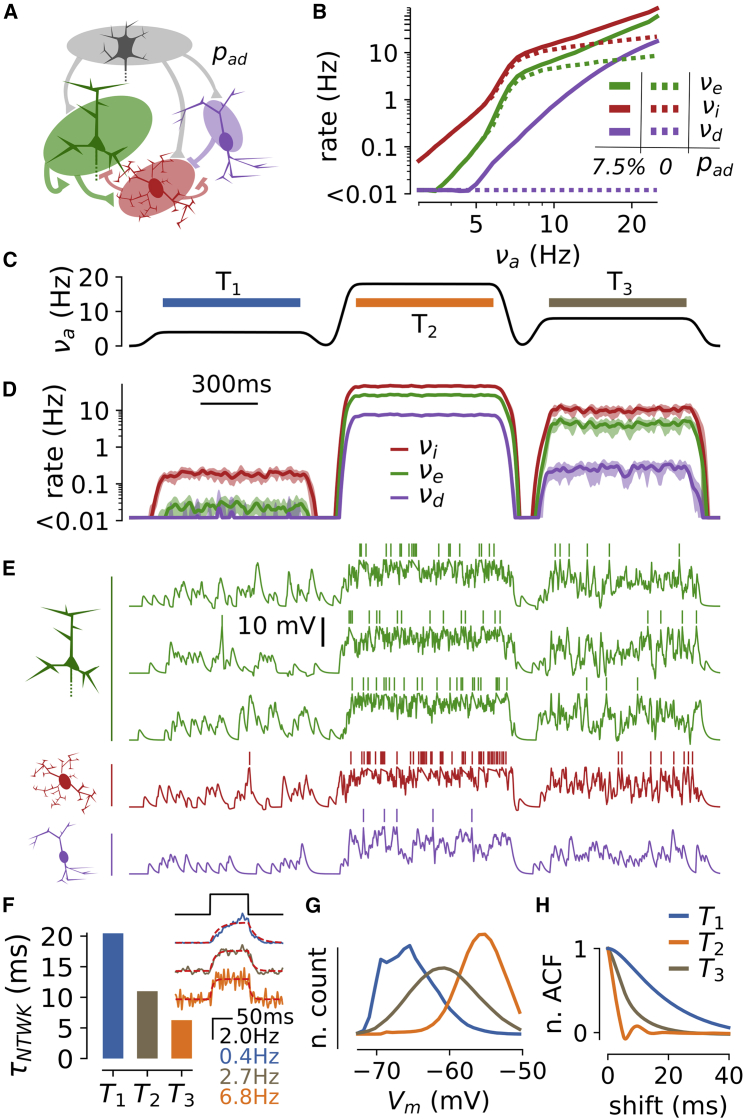
Modulation of Network Activity upon a Time-Varying Afferent Excitation(A) Schematic of the network model including the disinhibitory circuit. The parameter pad corresponds to the connection probability between the afferent and disinhibitory populations.(B) Stationary co-modulations of the excitatory (νe, green), inhibitory (νi, red), and disinhibitory (νd, purple) rates in absence (pad=0, dashed line; reproduced from Figure 1B) and in the presence of a disinhibitory circuit (solid line, pad=7.5%).(C–E) Network dynamics in response to a time-varying input.(C) Waveform for the afferent excitation.(D) Temporal evolution of the instantaneous firing rates (binned in 2-ms windows and smoothed with a 10-ms-wide Gaussian filter) of the excitatory (νe, green), inhibitory (νi, red), and disinhibitory (νd, purple) populations. Mean ± SEM over n = 10 trials. Time axis as in (C).(E) Membrane potential traces in a trial (green, excitatory cells; red, inhibitory cell; purple, disinhibitory). To highlight mean depolarization levels, the artificial reset and refractory mechanism has been hidden by blanking the 10 ms following each spike emission (see also Figure S6). Time axis as in (C).(F) Network time constants τNTWK for the three different levels of afferent activity considered in (C) (blue, νa = 4 Hz; orange, νa = 18 Hz; brown, νa = 8 Hz). The time constant was determined by stimulating the network with a 100-ms-long step input of afferent activity of 2 Hz (black curve in the inset) and fitting the trial-average responses with an exponential rise-and-decay function (red dashed curves, see STAR Methods). We show the average over 100 stimulus repetitions of the network responses in the inset.(G and H) Pooled membrane potential histograms for the three different stimulation periods (G) and pooled normalized autocorrelation functions (H).Data were obtained by pooling together the Vm after blanking spikes over 100 excitatory neurons in each interval for a single network simulation.See also Figure S5 and Table S2.